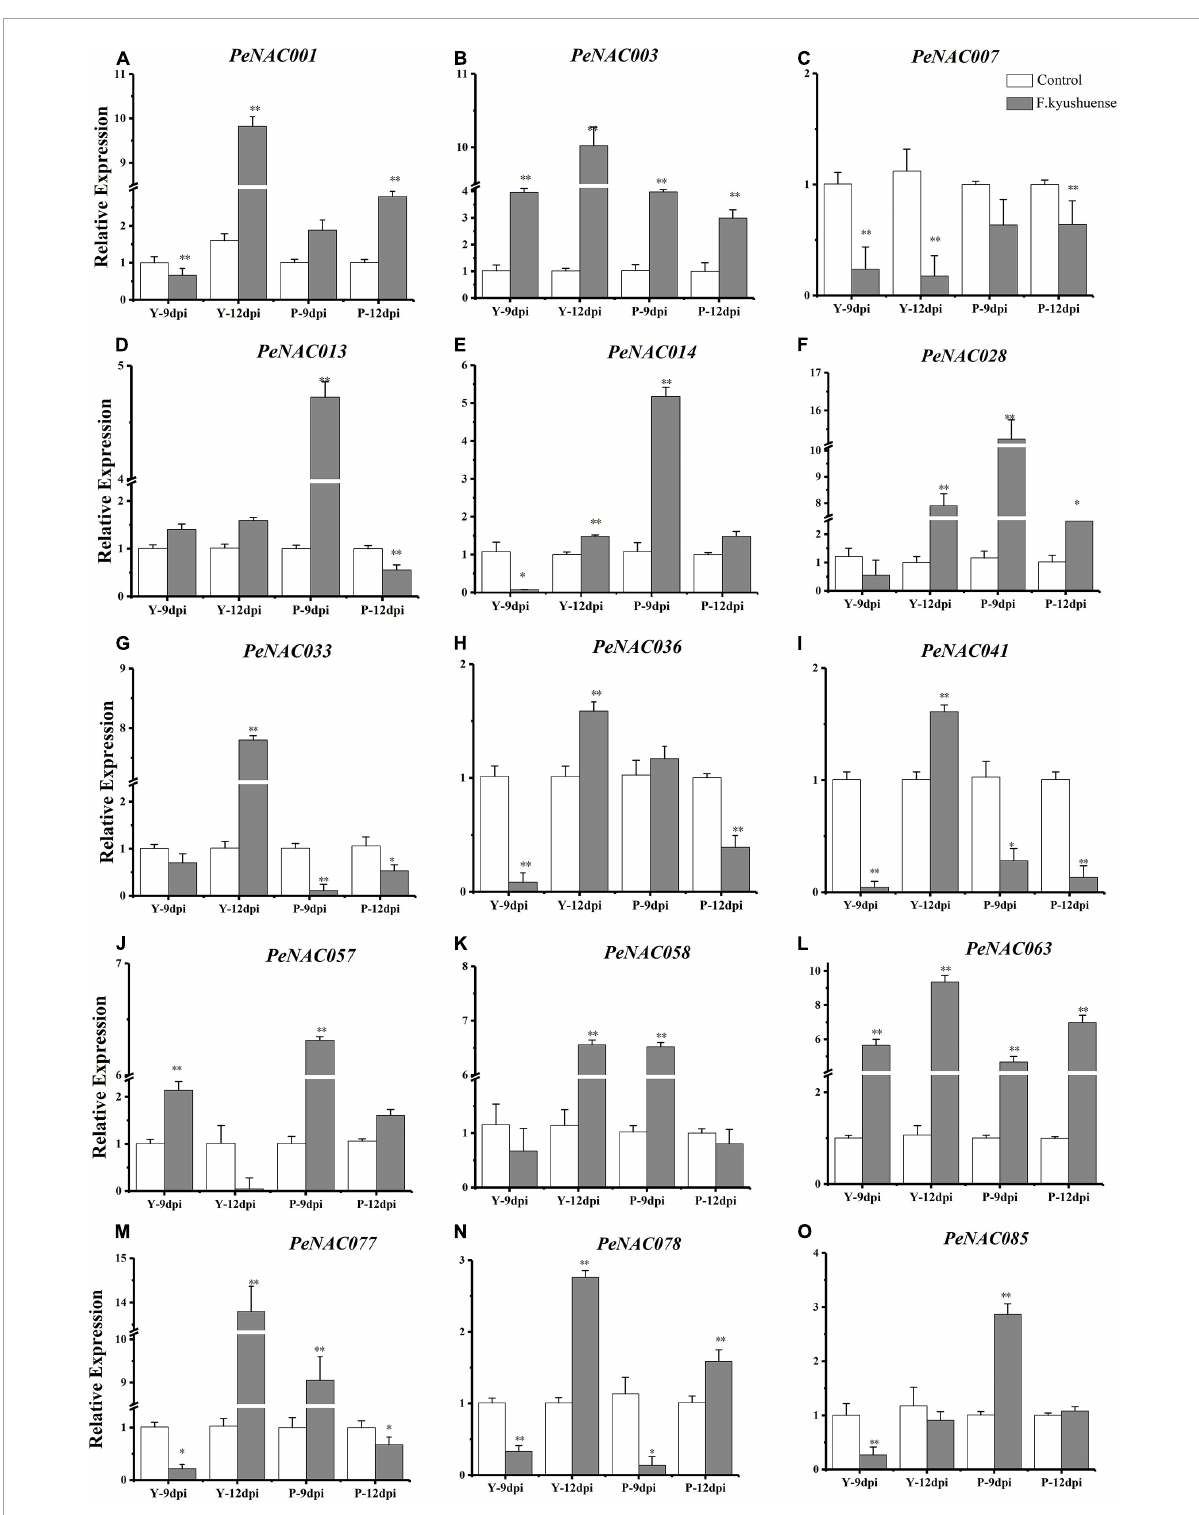
FIGURE12 The relative expressions of PeNAC genes in peel tissues of yellow and purple passion fruits under F. kyushuense fungal biotic stress and control conditions (A–O ). The relative gene expression levels were calculated using the 2 − (cid:49)(cid:49) Ct . Vertical bars represent means ± SD ( n = 3). The* and ** show significance at p ≤ 0.05 and p ≤ 0.0. Y represents the yellow passion fruit; P represents the purple passion fruit; and dpi represents the days